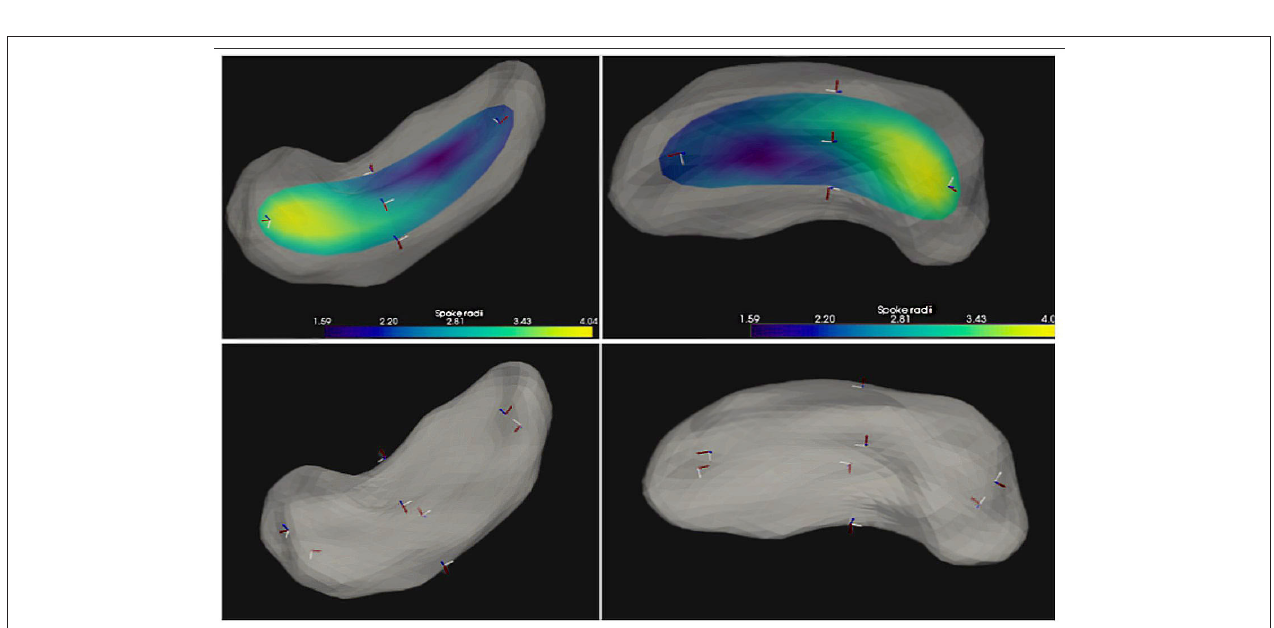
FIGURE 7 | Skeleton and fitted frames for a hippocampus from two points of view. Upper 2 panels: frames on the skeletal locus, colored by object width, where blue the object is thin, and where yellow it is thicker. Five fitted frames are shown on the skeleton, with the normal shown in blue; their orientation carries information as to the curvature of the skeleton. Lower two panels: the hippocampus boundary with fitted frames at points at ends of spokes at the skeletal points in the middle